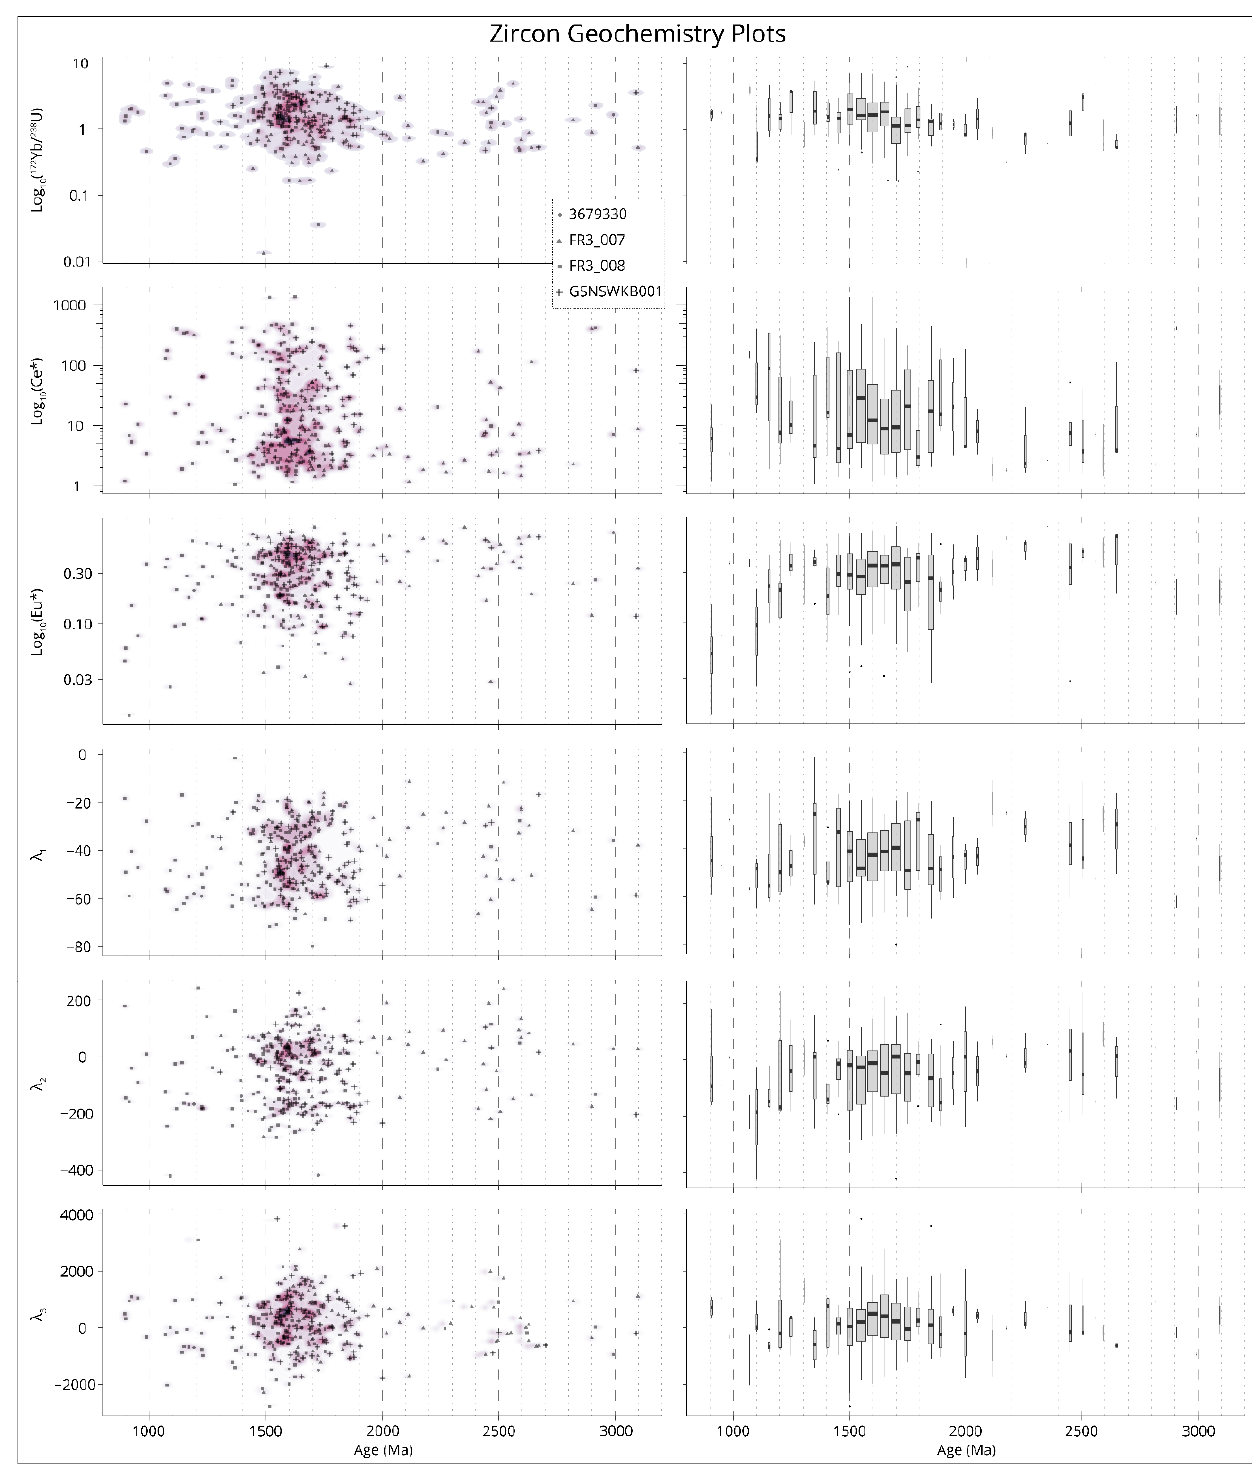
Figure 9. Key zircon geochemistry plots for zircon analysed in this study. Left: scatterplots underlain with 2D density estimation. Right: 50-million-year binned boxplots with width scaled by the count of values in the bin. Top to bottom: Yb/U, Ce*, Eu*, and λ 1–3. λ 1–3 are measures of lanthanoid pattern shapes, with λ 1–3 representing the linear slope, quadratic slope, and cubic slope, respectively. Ce*, Eu*, and λ 1–3 were calculated using BLambdaR [120].